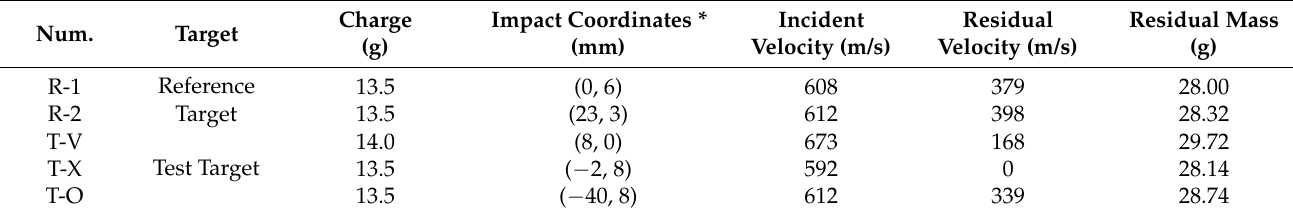
Table 2. Experimental results of projectile impacts on the test and reference target.